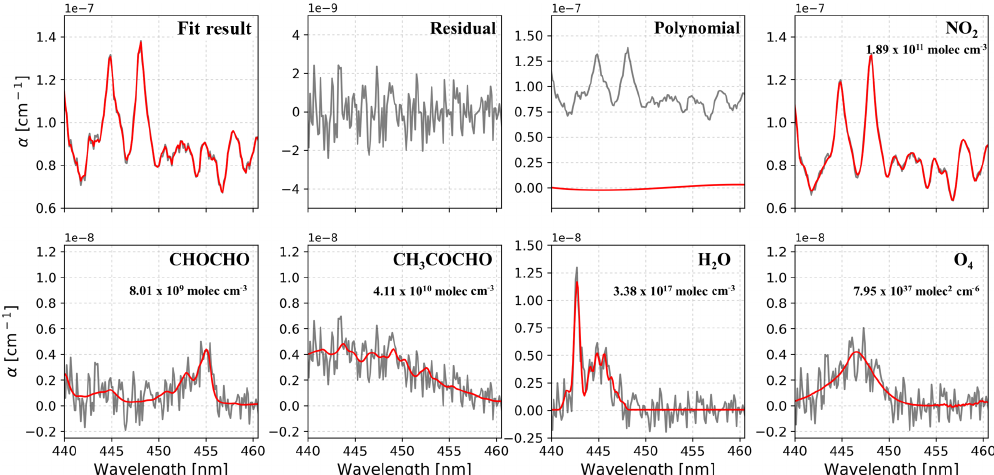
Figure 6. An example of spectral fit for one spectrum (60s average) measured during the YRD campaign. Retrievals of NO 2 , CHOCHO, CH 3 COCHO, H 2 O, and O 4 are shown, as well as the fifth-order polynomial, total fit, and residual. Red is the fitted spectrum and black is the fitted result plus residual.